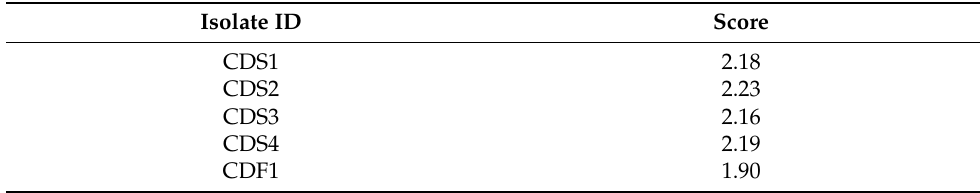
Table 2. Identification spectral score of MALDI-TOF MS of C. difficile